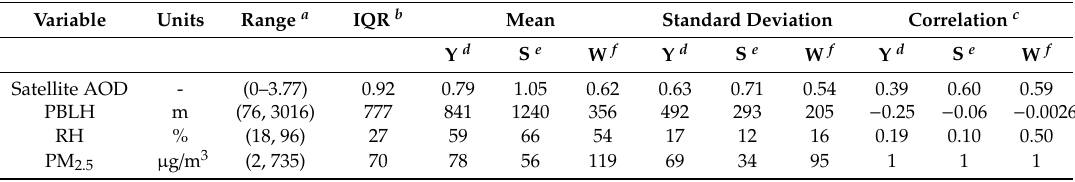
Table 2. Statistics for the 2015 dataset.